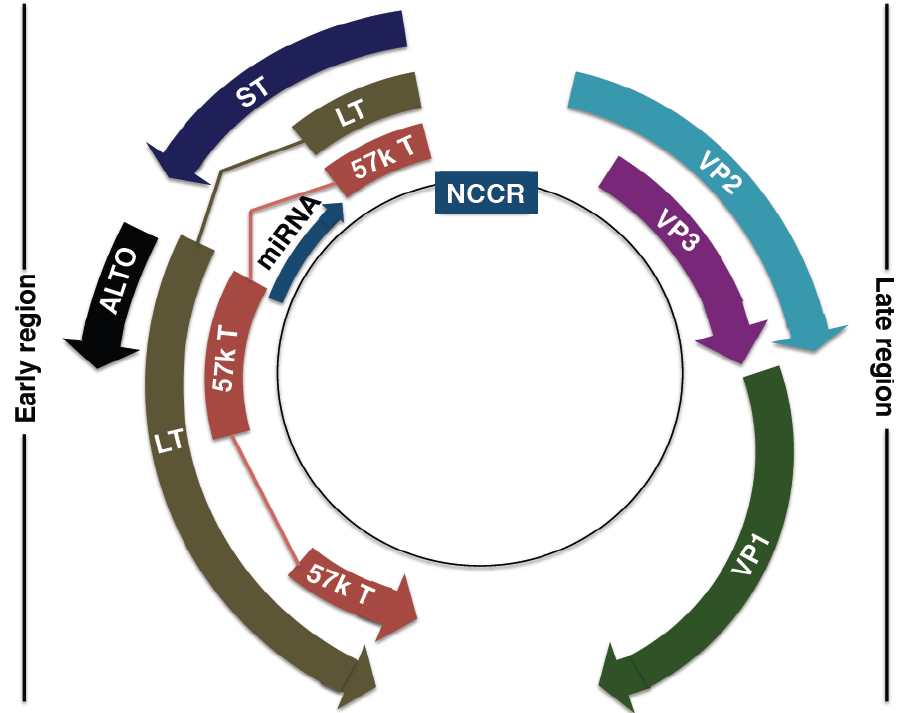
Figure 3. MCPyV genome organisation. Non-coding control region (NCCR): bipartite origin of replication. Early gene region: Large T antigen (LT), small T antigen (ST), 57kT antigen (57kT), alternative T antigen open reading frame (ALTO), microRNA (miRNA). Late gene region: capsid proteins